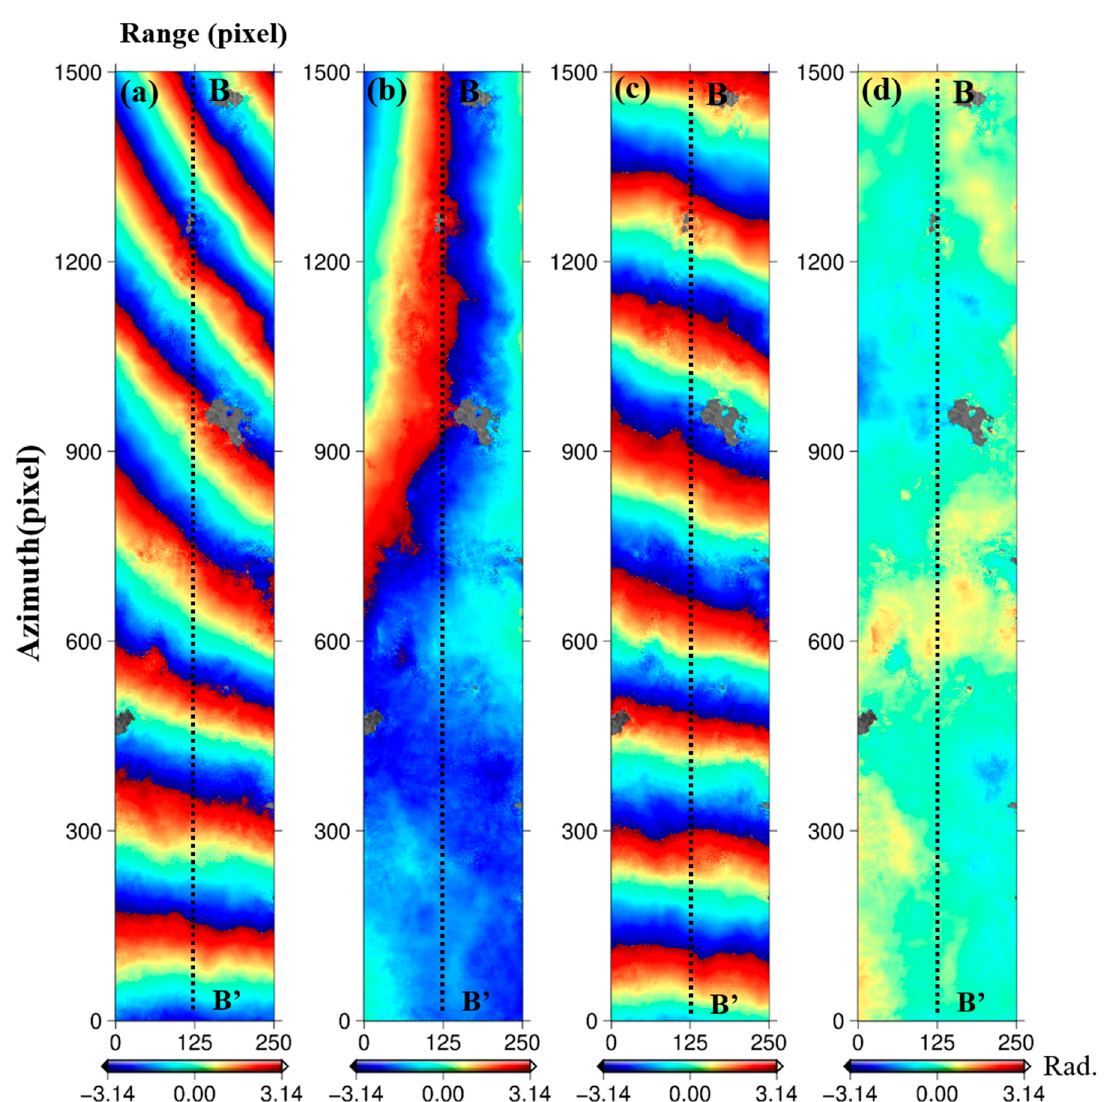
Figure 11. HH-polarized original and corrected interferogram. ( a ) Original interferogram, ( b ) residual-ionosphere-corrected interferogram by subtracting the fitted residual ionospheric phase from Figure 11a, ( c ) ionosphere-corrected interferogram by subtracting ionospheric phase from Figure 11a, ( d ) integration-corrected interferogram by subtracting the fitted phase in (11) from Figure 11a.